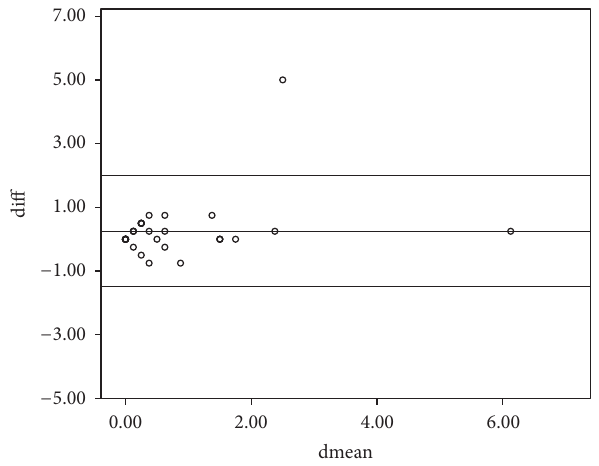
Figure 4: Bland-Altman plots comparing refractive measurements between retinoscopy and subjective refraction (total